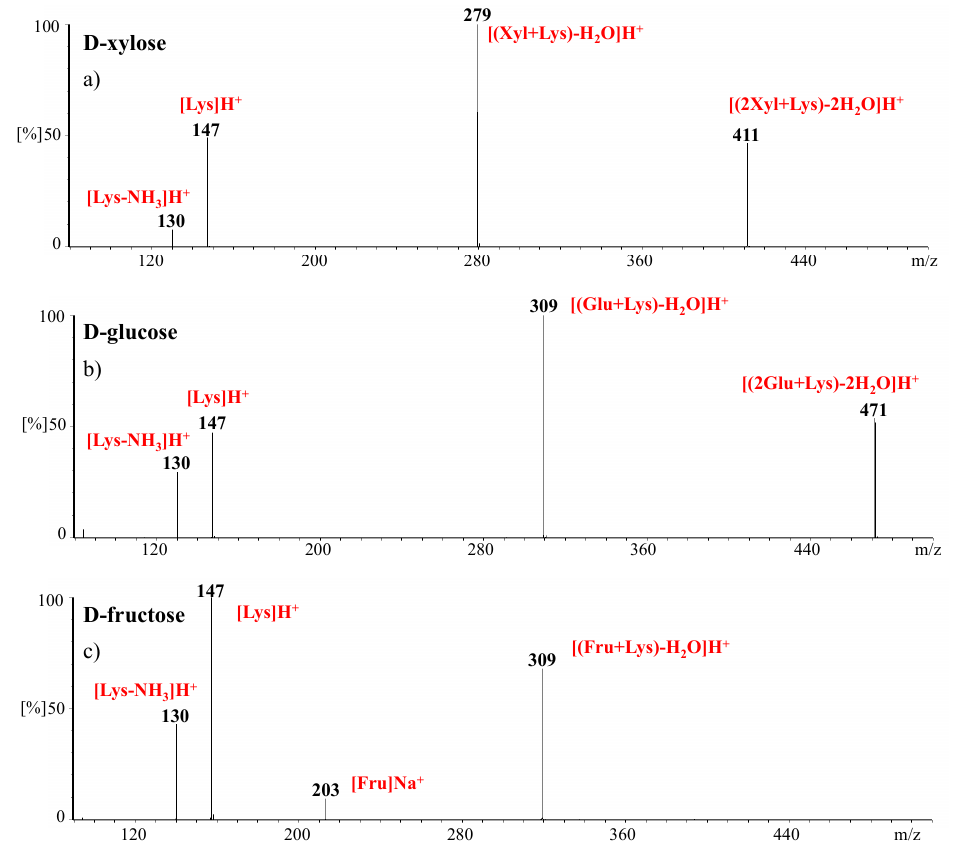
Figure 2. The ESI mass spectra of the solutions obtained by rinsing the solid precipitate generated by the ESI microdroplet deposition of: ( a ) 1 mL of 1:1 L-lysine/D-xylose 10 − 3 M H 2 O/CH 3 OH 3:1 solution; ( b ) 1 mL of 1:1 L-lysine/D-glucose 10 − 3 M H 2 O/CH 3 OH 3:1 solution; ( c ) 1 mL of 1:1 L-lysine/D-fructose 10 − 3 M H 2 O/CH 3 OH 3:1 solution.